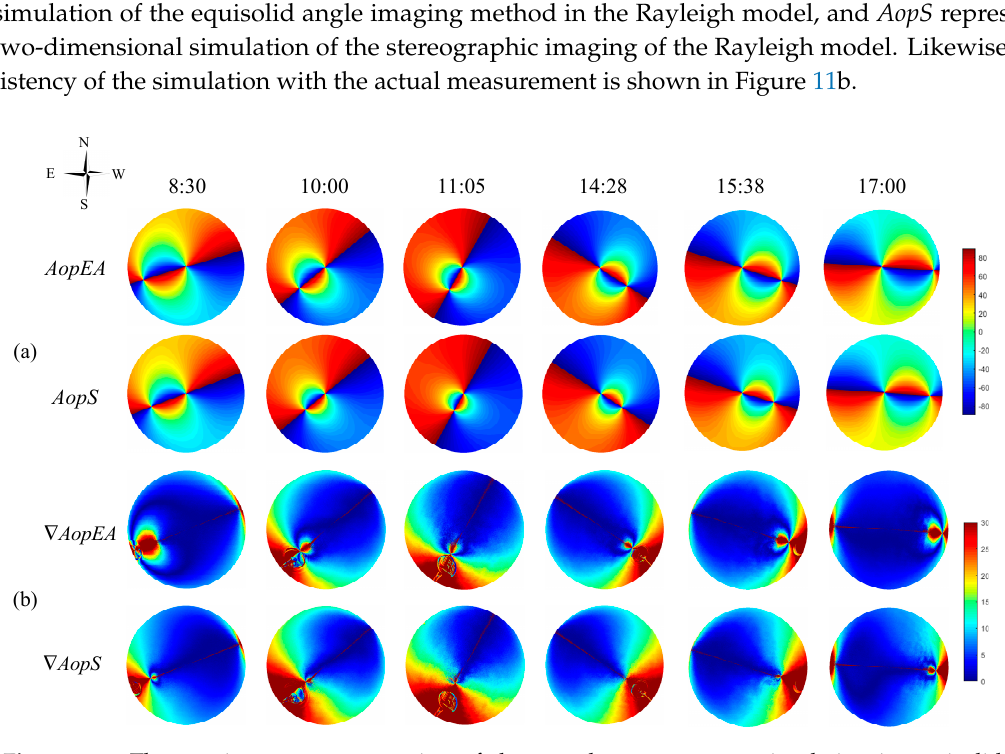
Table 3. Similarity and improvement of equisolid angle imaging, stereographic imaging, two- dimensional Rayleigh simulation, and actual measurement. Time